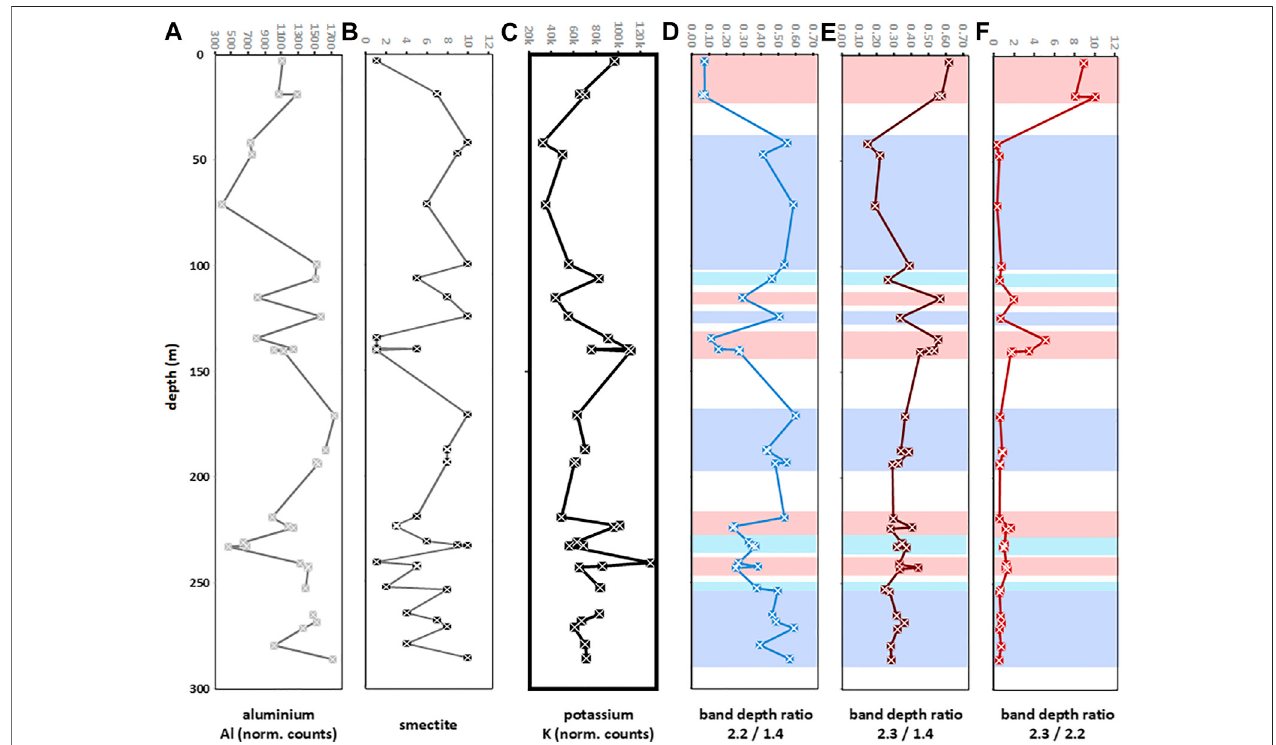
FIGURE6| Comparisonofabsorptionbandratiosat2.2/1.4,2.3/1.4and2.3/2.2(hyperspectralanalysis) (D – F) fortheCHB14-2sampleswithelementalvariations (XRF, A, C ) and semiquantitative phase abundances (XRD, B )ofanalyzed samplesdowncore. (A) Aluminum, (B) smectite, (C) potassium, (D) 2.2/1.4 banddepth ratio, (E) 2.3/1.4 band depth ratio, and (F) 2.3/2.2 band depth ratio. CHB potassium values (K) (scanning XRF, in normalized counts per second) show an inverse correlation withsmectiteabundances (XRD)incorrespondingsamples.Alcontent(scanning XRF,innormalized counts per second) largelyfollowsmectiteabundances (XRD) that are typically rich in Al. Color shading indicates inferred hydroclimate: red: dry-climate sediment; light blue: wet-to-dry-transition-climate sediment; blue: wet-climate sediment, derived from spectral analysis.